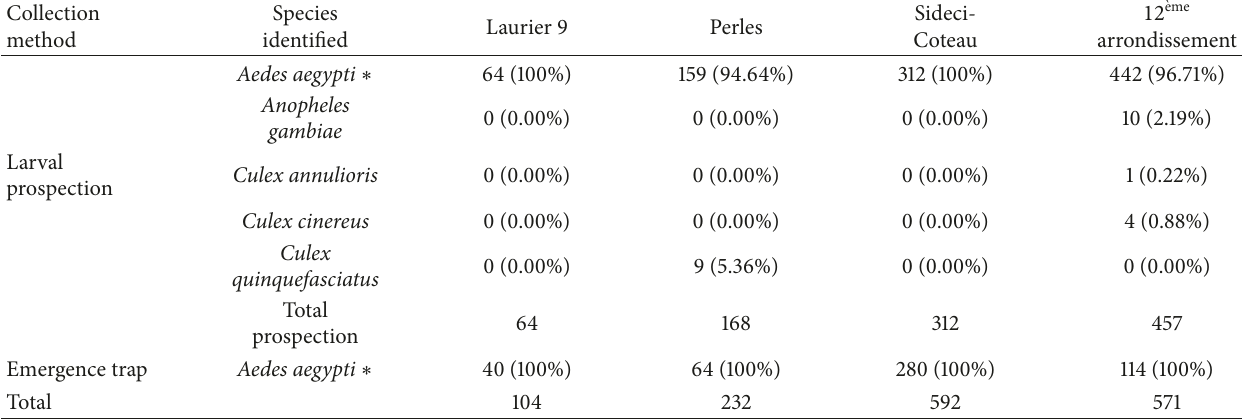
Table 1: Culicids fauna collected from different sampled